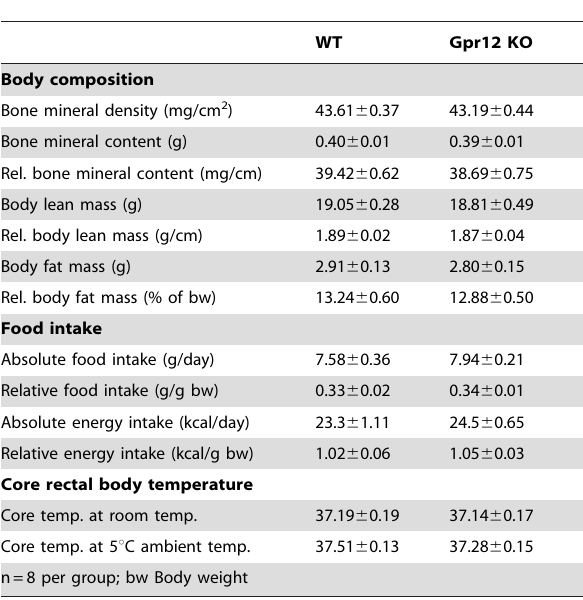
Table 1. Body composition, food intake and body temperature of wild type (WT) and Gpr12 deficient (Gpr12 KO) mutant mice – Swedish